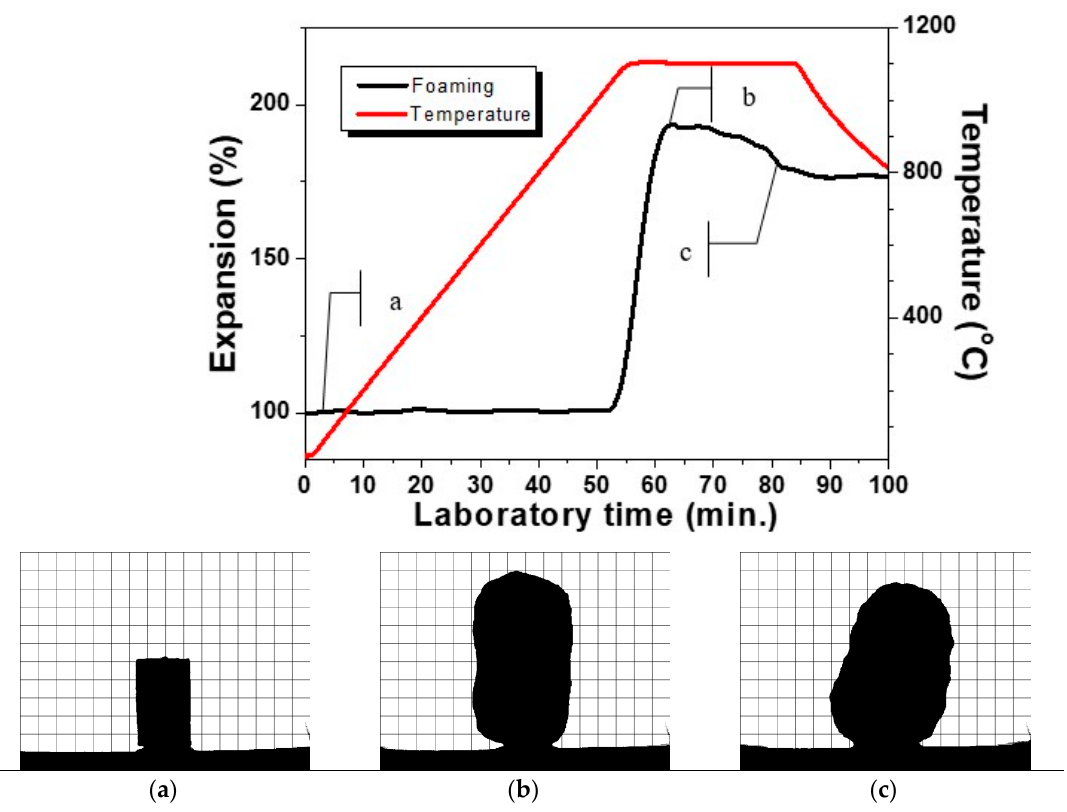
Figure 6. HSM sintering curve during the formation of a glass ceramic foam at a temperature of 1100 °C; ( a – c )—silhouette images during the bloating process.